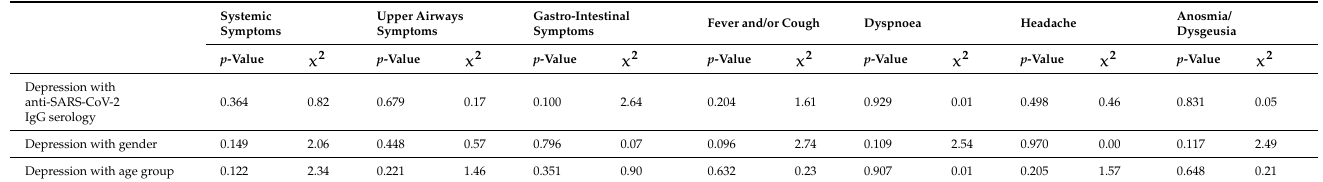
Table A7. Interaction effects between depression scores with serology status, gender and age group at baseline (July 2020), Ticino (N =